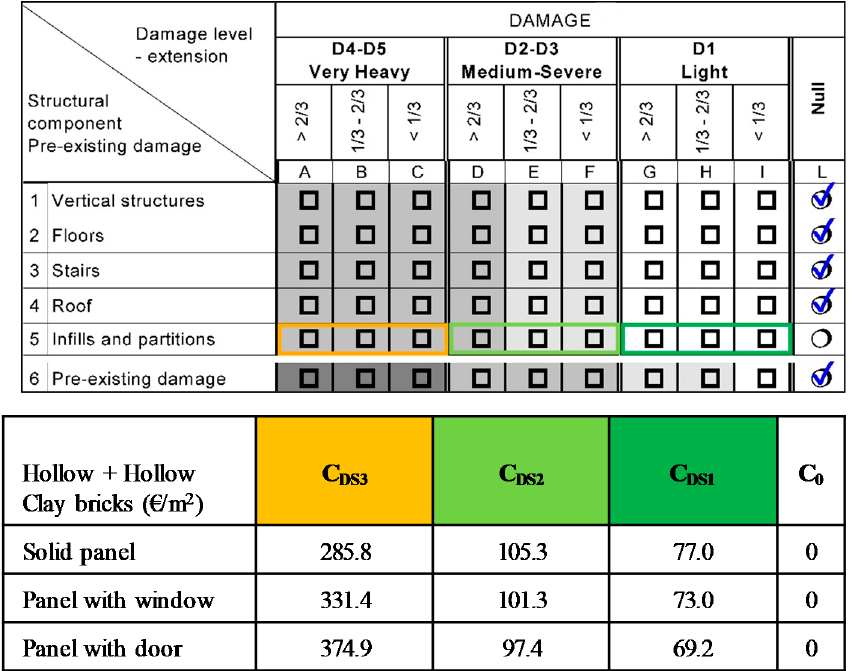
Figure 11. Repair costs (